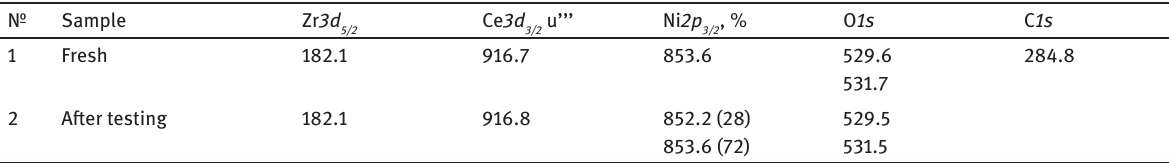
, Ce 3d -u’’’ , O 1s и Ni 2p 5/2 3/2